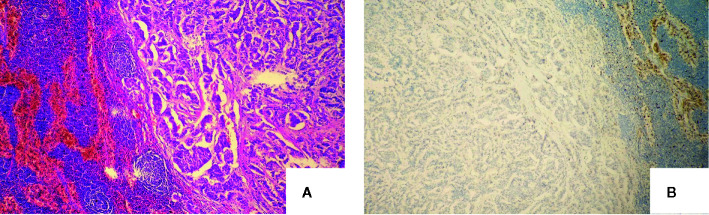
Definitive pathology of lymph nodes of the second operation with the microscopy and immunochemistry evaluation: (A) Recurrence of lateral cervical lymph nodes (haematoxylin and eosin, original magnification, x 100); (B) Neoplastic cells were negativity immunoreactive for calcitonin (immunoperoxidase stain for anti-calcitonin, original magnification, x 100).